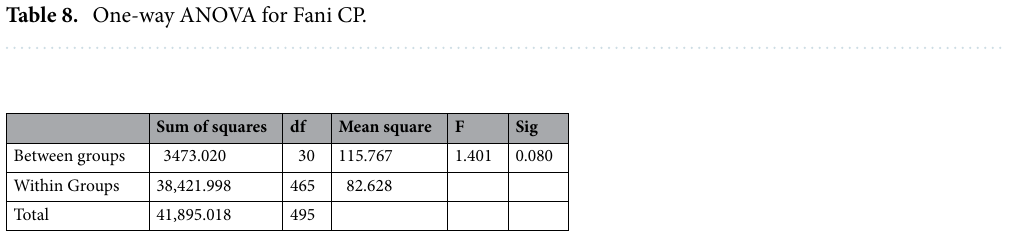
Table 8. One-way ANOVA for Fani CP.